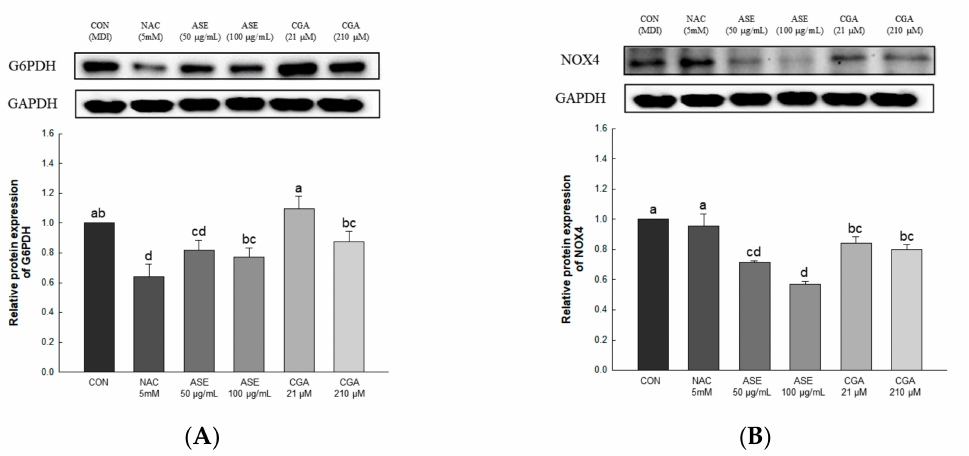
Figure 6. E ff ects of ASE and CGA on the expression level of ROS generating factor in 3T3-L1 adipocyte. Protein expression of G6PDH (A) and NOX4 (B). 3T3-L1 adipocytes di ff erentiated for 6 days were treated with ASE (50 and 100 µ g / mL) and CGA (21 and 210 µ M). Protein expression was quantified through western blotting and normalized through GAPDH expression level. Each value is expressed as the mean ± SD of triple determination. The other letters on the bars indicate a significant di ff erence of p < 0.05 in the Duncan multi-range test. a, d, ab, bc and cd significant di ff erences among various parts of